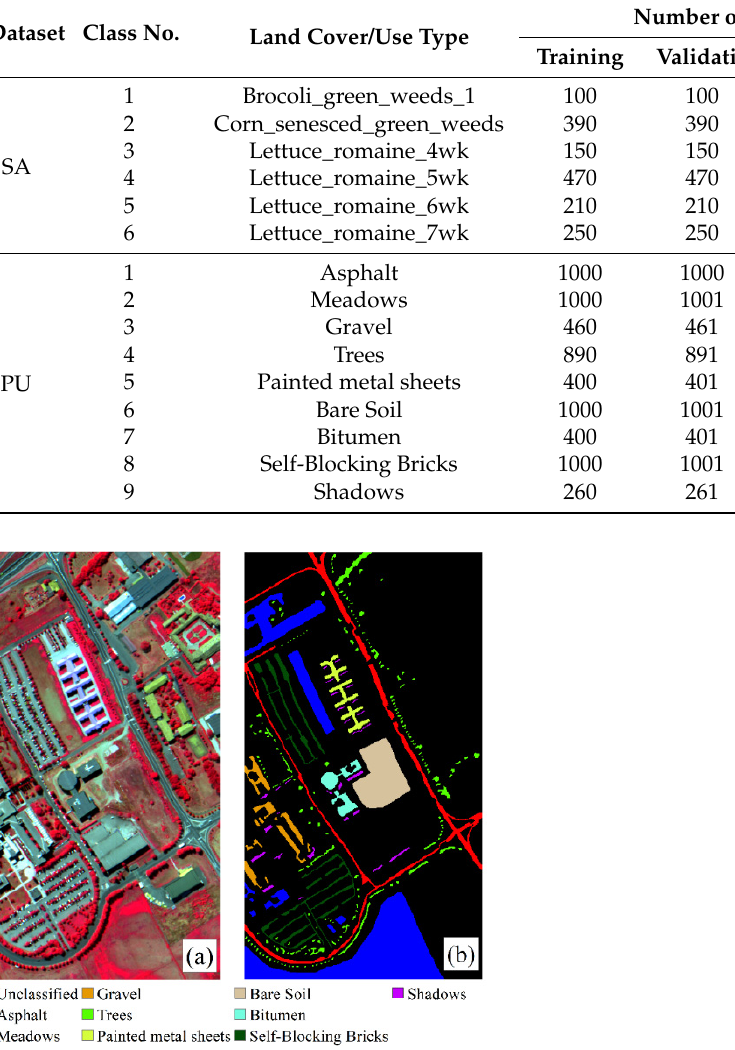
Figure 3. ( a ) The PU dataset; and ( b ) ground truth for the same area of Pavia University.